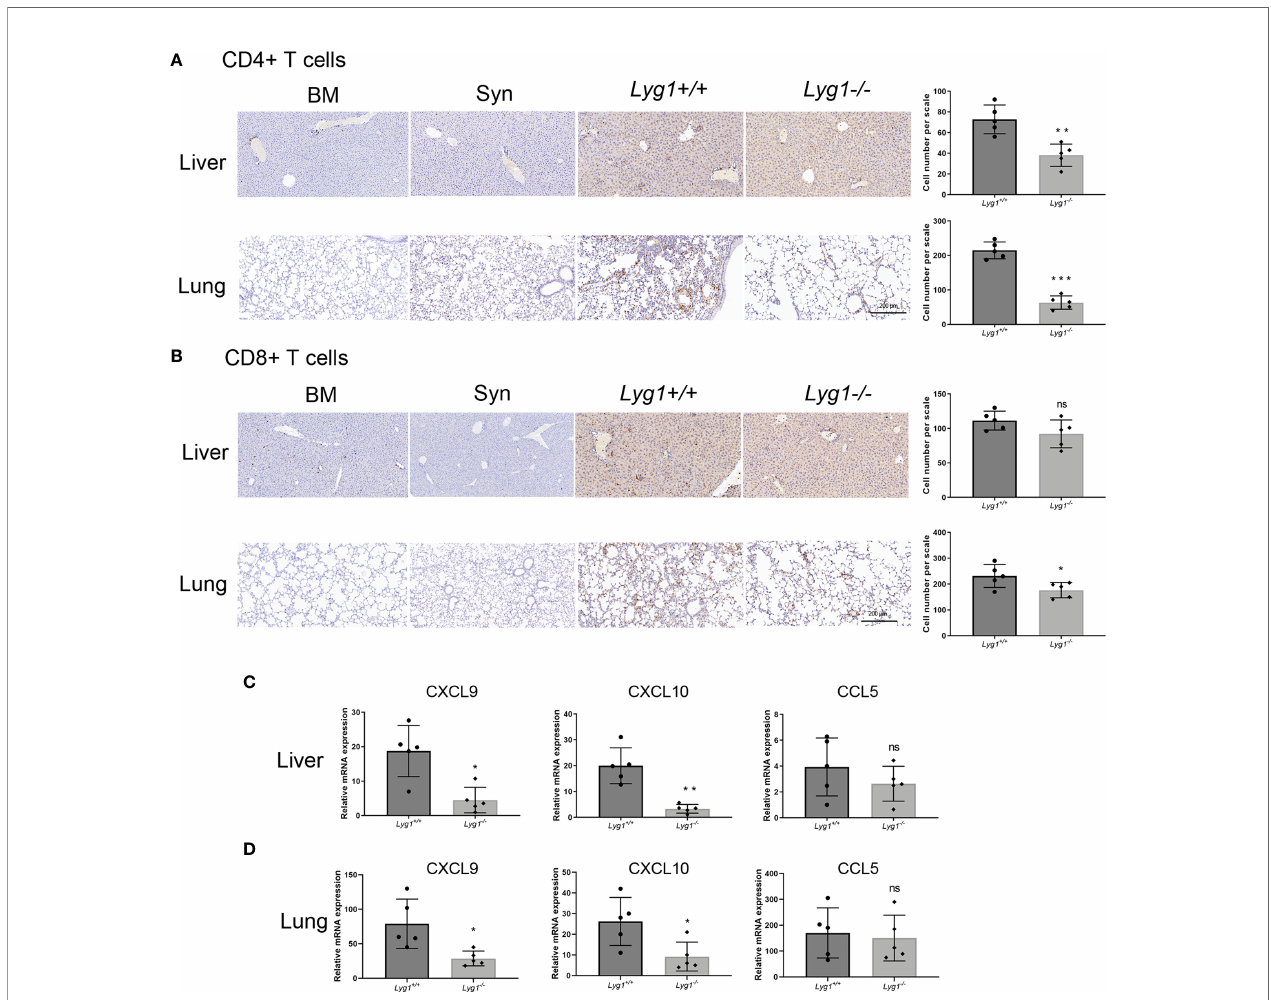
FIGURE 4 | LYG1 de fi ciency inhibited allogeneic CD4 + T cells in fi ltration in aGVHD target organs. The samples of livers and lungs were excised at day 7 after transplantation and stained with antibodies CD4 and CD8. (A, B) The in fi ltration of CD4 + T cells and CD8 + T cells in livers and lungs in BM, Syn group, or mice receiving Lyg1 +/+ and Lyg1 -/- donor T cells determined by IHC assay (×200 magni fi cation). The left is one representative section per group. The right is the number of CD4 + T cells and CD8 + T cells per scale in the livers and lungs. (C, D) Chemokines expression were examined by qPCR in lymphocytes isolated from livers and lungs. Independent experiment was performed 3 times. The results in the repeats were similar. n = 5 per group. Representative sections are shown and statistical results are expressed as the mean ± SD, *p < 0.05, **P < 0.01 and ***P < 0.001 compared with Lyg1 +/+ group. ns, no signi fi